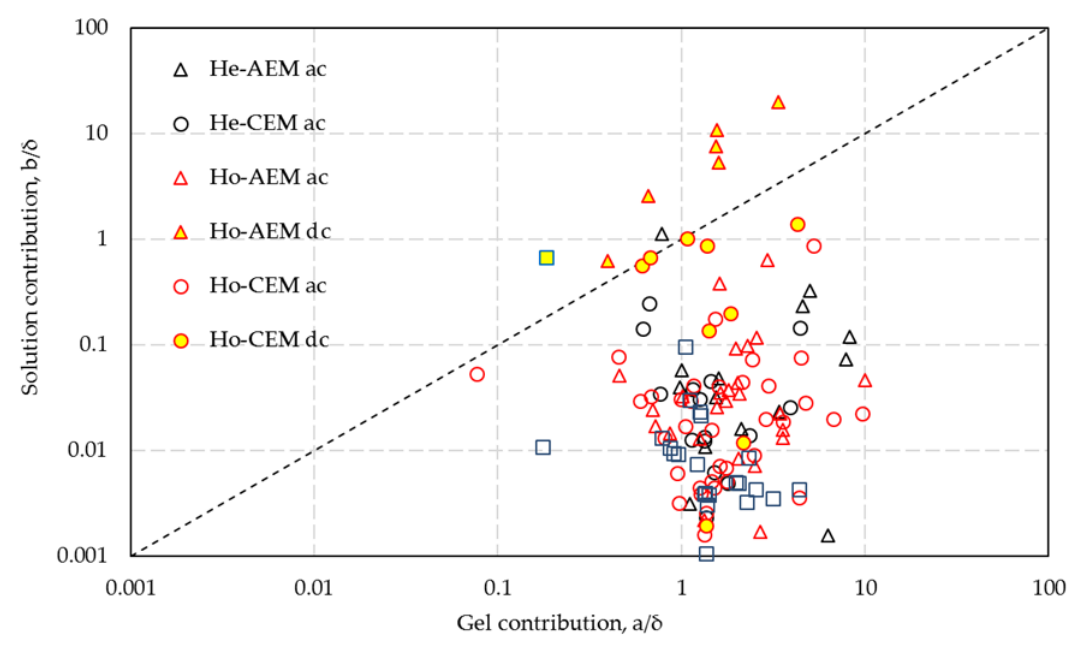
Figure 9. Fitted values for the contribution of a/õ (for the gel) and b/õ (for the solution) to the area resistance R = a + b/C. Different types of membranes are indicated in the legend: heterogeneous (He), homogeneous (Ho), and perfluoridated (PF) structures with anion exchange (AEM) or cation exchange (CEM) functionality. Yellow filled symbols indicate DC measurement; others are AC measured. Table 8. Mean values of the parameters a / δ , b / δ , and their ratio for direct current (DC) and alternating current (AC) measurement and for the whole set. a / δ b / δ ( a / δ ) / ( b / δ ) DC 1.39 0.352 3.95 AC